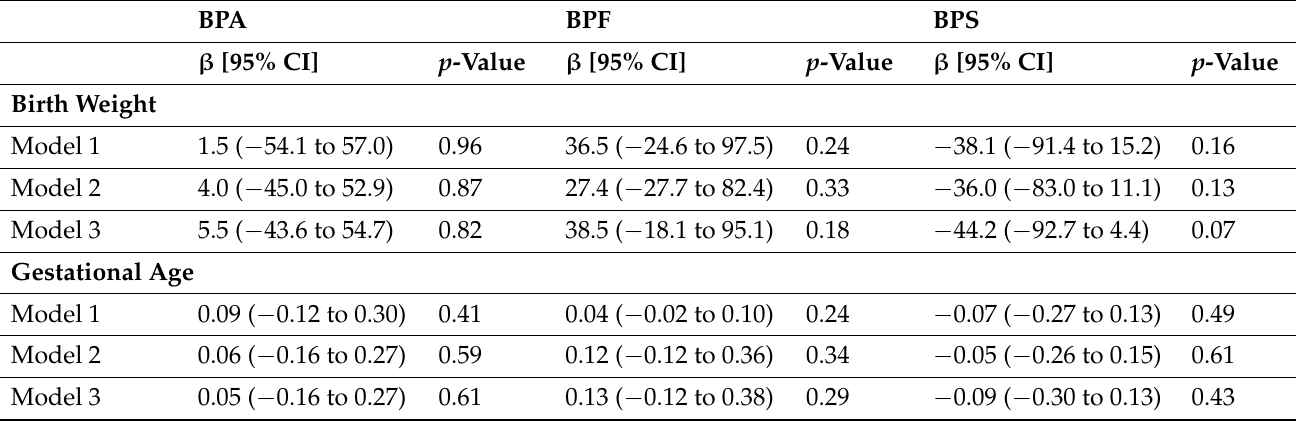
Table 3. Associations of the bisphenol concentrations with birth weight and gestational age for each 10-fold increase in the maternal urinary bisphenol level (specific-gravity corrected, µ